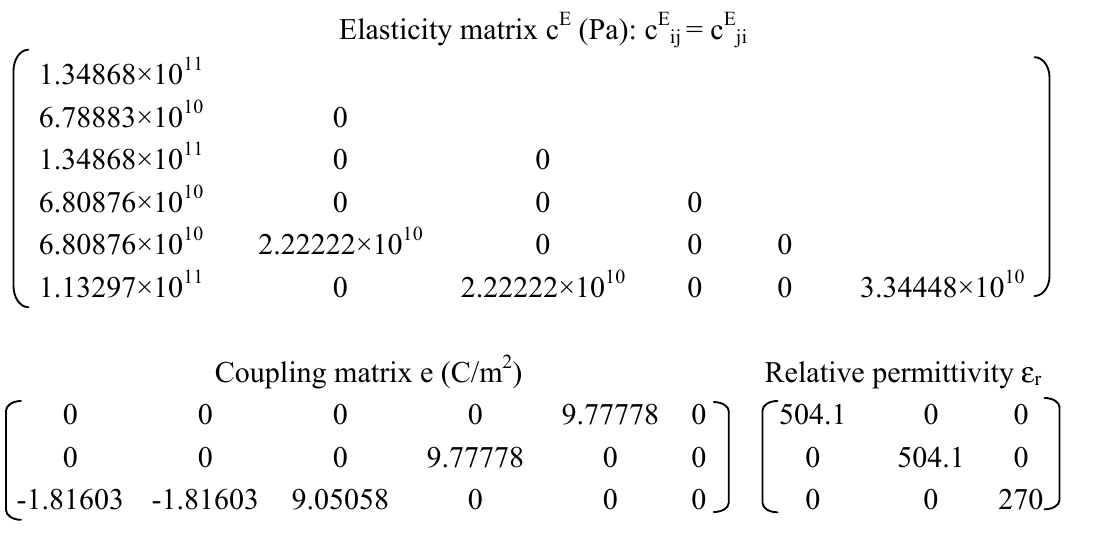
Figure 5. COMSOL simulation of the acoustic wave gravimetric sensor. ( a ) 3D model and surface displacement field at resonant frequency of 16.52 MHz. ( b ) Transverse displacement along thickness of the AT-cut quartz